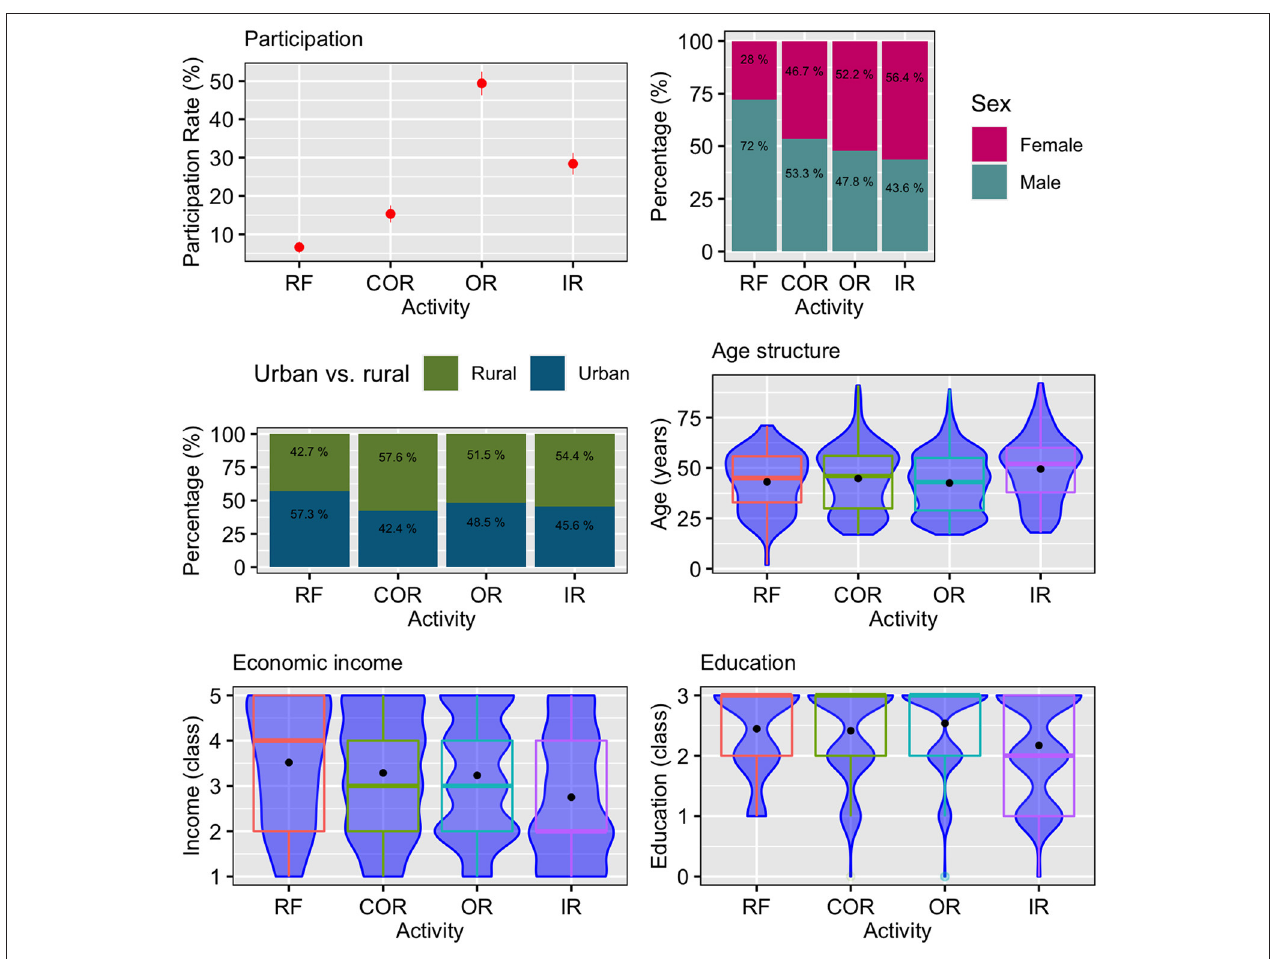
FIGURE 2 | Participation rate (%) and demographic characteristics of the four outdoor and indoor recreational activities considered: Recreational Fishing (RF), Consumptive Outdoor Recreation (COR), Outdoor Recreation (OR), and Indoor Recreation (IR). The plot shows the estimated participation rate of the Spanish adult population (based on 38,659,649 people in 2017), the percentage of men and women, and urban vs. resident of each profile, the age structure, the economic income (the higher, the larger income), and education (the higher, the higher education level) as classes (as numeric variable, see the main text for a detailed description of each class). Age, economic income, and education are shown as numeric variables and a violin (density plot) and